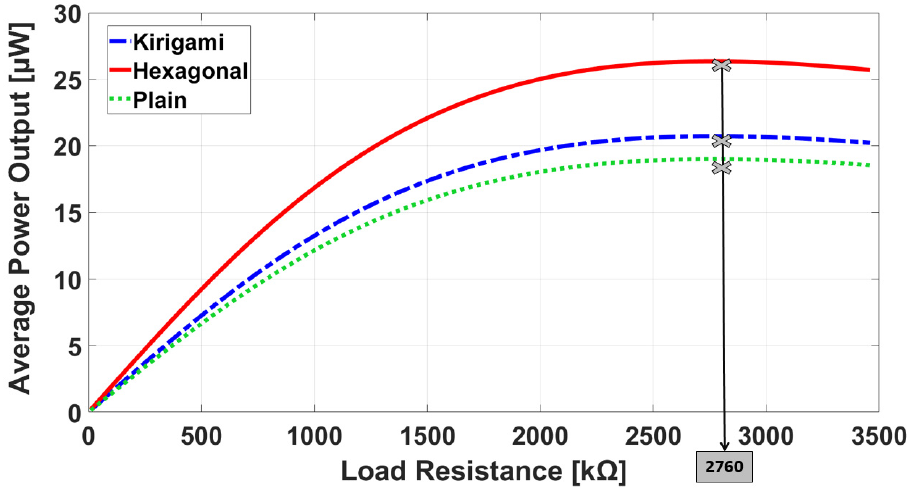
Figure 13. Simulated average power output against load resistance for the sensors.